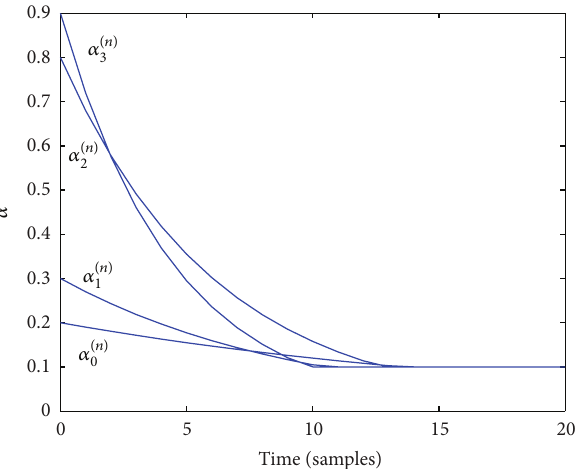
Figure 3: Evolution of the time-varying weights 𝛼 (𝑛) 0 , 𝛼 (𝑛) 1 , 𝛼 (𝑛) 2 , and 𝛼 (𝑛) 3 through (36).